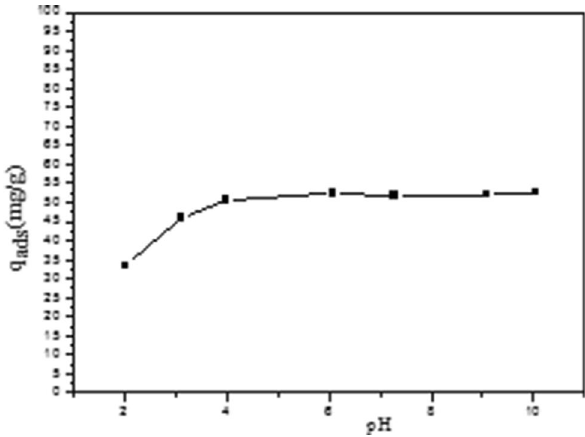
Fig. 5 Effect of the pH for the equilibrium adsorption data of Rh6G on composite ( C 0 = 100 mg/cm 3 , T = 23 °C, equilibrium time = 24